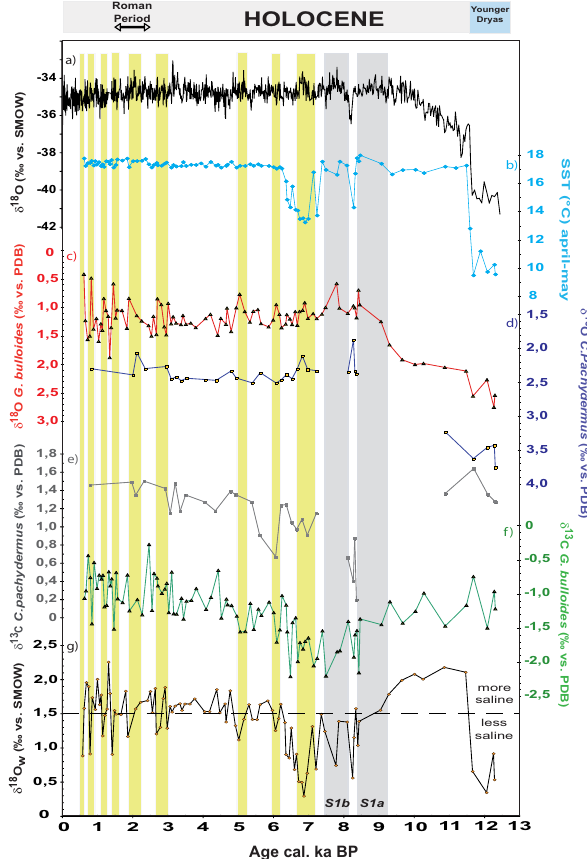
Fig. 3. Climatic record from core MD90-917 and comparison with Greenland ice core since the Younger Dryas–Holocene tran- sition vs. age (cal.kaBP): (a) oxygen isotope record from GISP 2 ice core. (b) April–May sea surface temperature as determined by the modern analog technique (MAT). (c) δ 18 O of the plank- tonic foraminifera Globigerina bulloides . (d) δ 18 O of the ben- thic foraminifera Cibicidoides pachydermus . (e) δ 13 C of the ben- thic foraminifera Cibicidoides pachydermus . (f) δ 13 C of the plank- tonic foraminifera Globigerina bulloides . (g) Calculated sea water δ 18 O record ( δ 18 O w ) generated from the SST by MAT and G. bul- loides δ 18 O by solving the paleotemperature equation of Shackle- ton (1974); dashed line corresponds to modern δ 18 O w values in the South Adriatic after Pierre (1999). S1a and S1b refer to the two-step sapropel S1 deposition. Yellow bars indicate low δ 18 O w /salinity